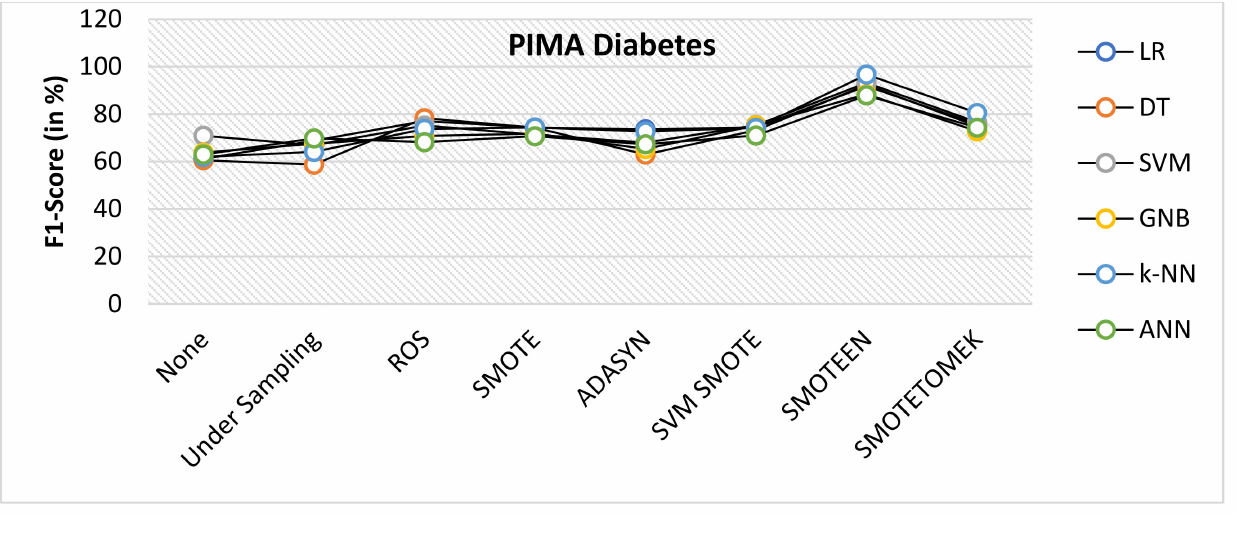
Figure 25. F1 score for diabetes dataset of balancing algorithms over six